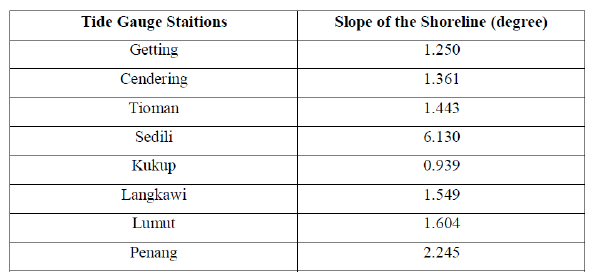
Table 3. Coordinates of Point A and Point B Table 4 stated the angle of the slope of the shoreline for all the tide gauge station used in this research.